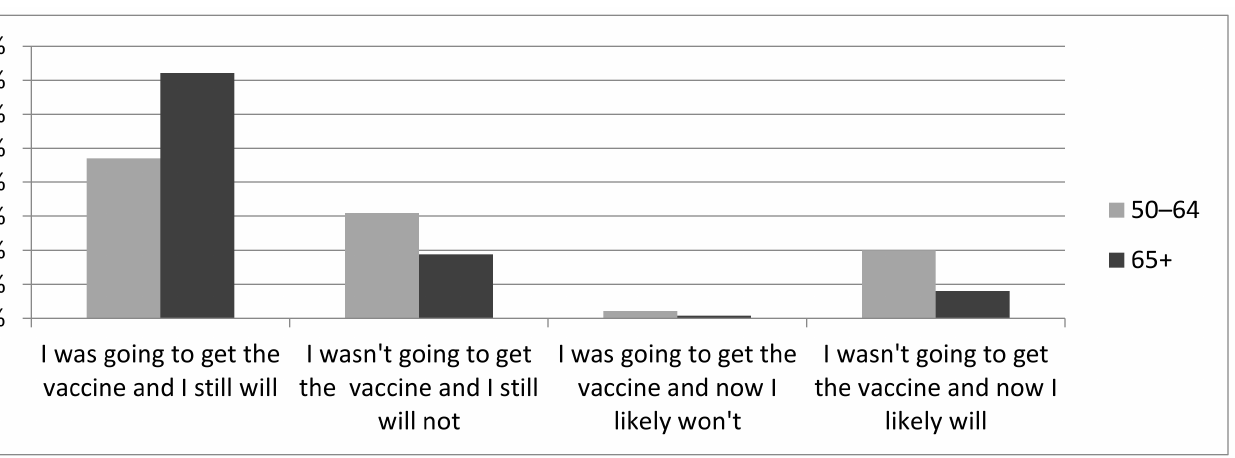
Figure 1. Impact of COVID-19 on decision to receive or abstain from influenza vaccine.